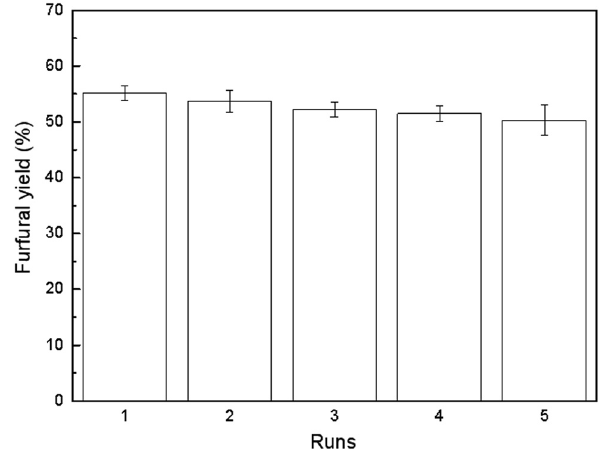
Figure 6: Reusability of the G/F - 1/4 catalyst. Reaction